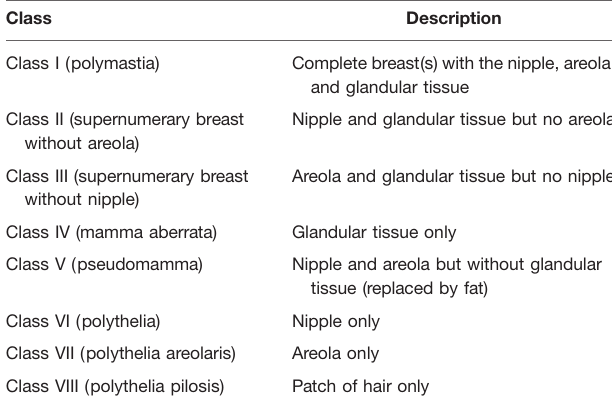
TABLE 1 | Kajava classi fi cation of ectopic breast tissue.